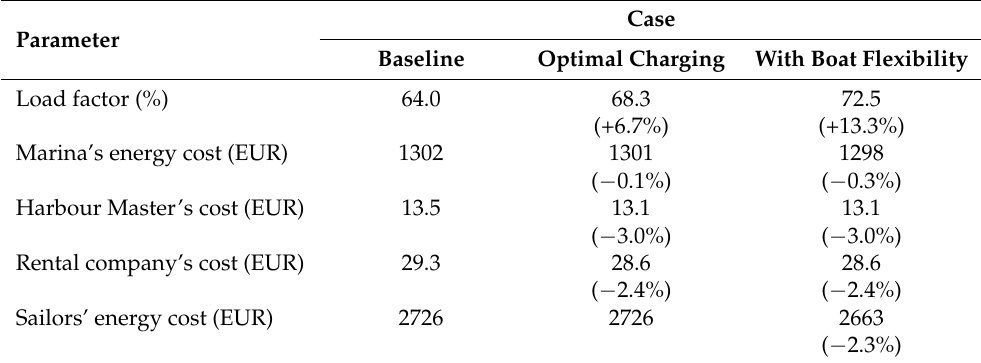
Table 3. Simulation results for optimal charging strategy and boat flexibility for a